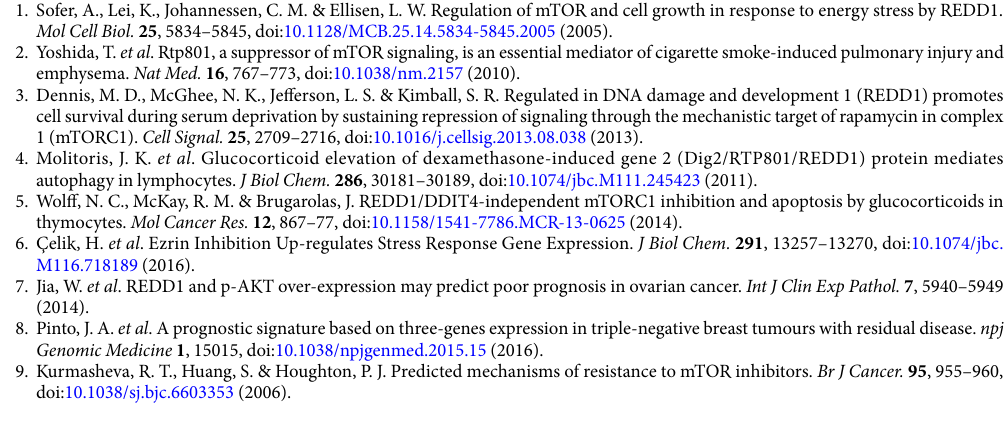
Correlation of mTOR drug activities and DDIT4 and MTOR expression. Data transformed to Z-score of mTOR inhibitors and DDIT4 and MTOR mRNA expression was downloaded from the Cell Miner Tool website (http://discover.nci.nih.gov/cellminer/). NSC identifiers were 226080, 606608 and 758664 for rapamycin, 683864 for temsirolimus, 733504 for everolimus and 759660 for OSI-027. Correlation between mRNA expression of 60 cancer cell lines with drug sensitivity in them was done with a regression analysis and correlation coefficient (R-square) was estimated. Nanostring analysis and next-generation sequencing. DNA and RNA were extracted from 58 formalin-fixed and paraffin-embedded triple negative residual tumors after neoadjuvante chemotherapy. Gene expression analysis was performed by nanoString and PI3K/mTOR pathway genes were sequenced by next-generation sequencing as previously described 26, 27 . Gene expression values obtained from nanoString were normalized with spike controls, log2 transformed and median centered before the statistical analysis.